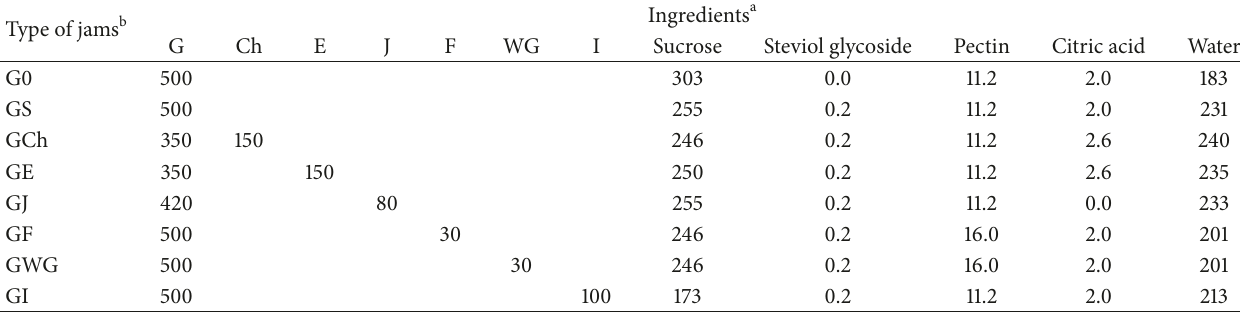
Table 1: Recipes of gooseberry jams, g/kg of finished product.